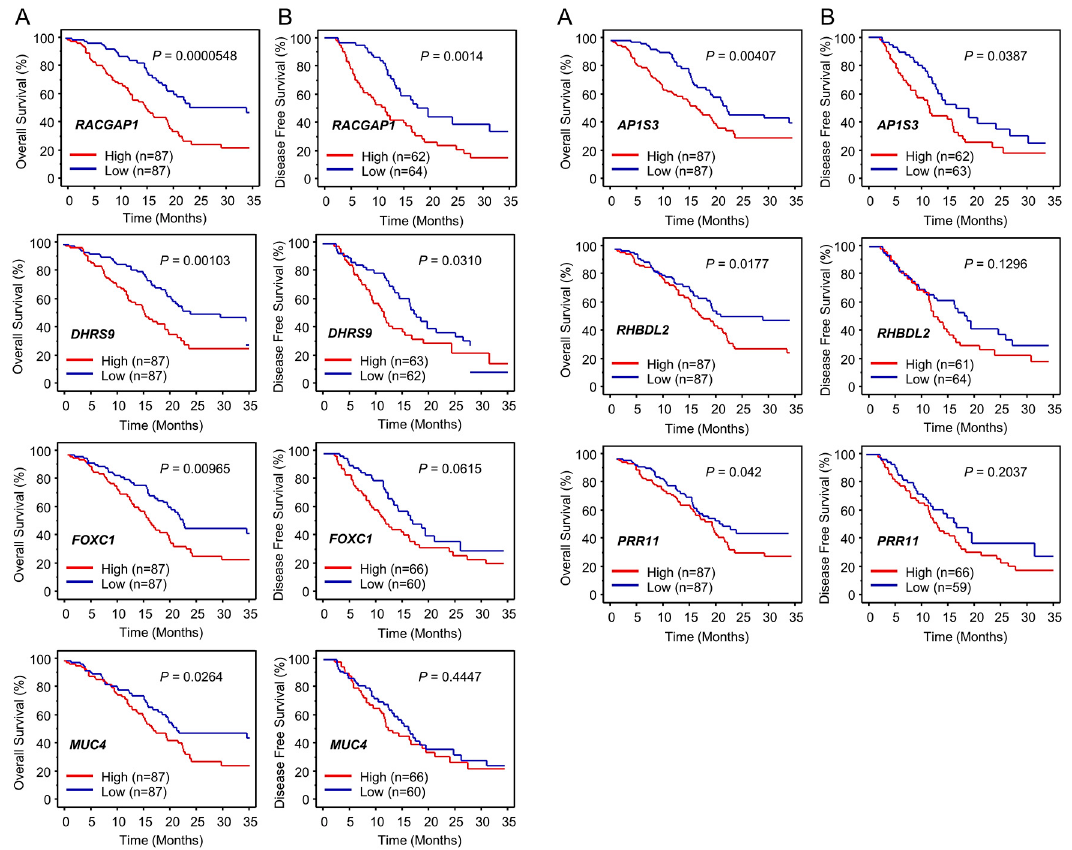
Figure 2. Clinical significance of the expression levels of seven genes targeted by miR-204-5p ( RACGAP1 , DHRS9 , AP1S3 , FOXC1 , PRP11 , RHBDL2 and MUC4 ) based on data from The Cancer Genome Atlas (TCGA) database. ( A ) Kaplan-Meier plots of overall survival and ( B ) disease-free survival with log-rank tests comparing the survival of PDAC patients with high (red lines) versus low (blue lines) expression levels of each of the abovementioned genes, based on data from TCGA database.